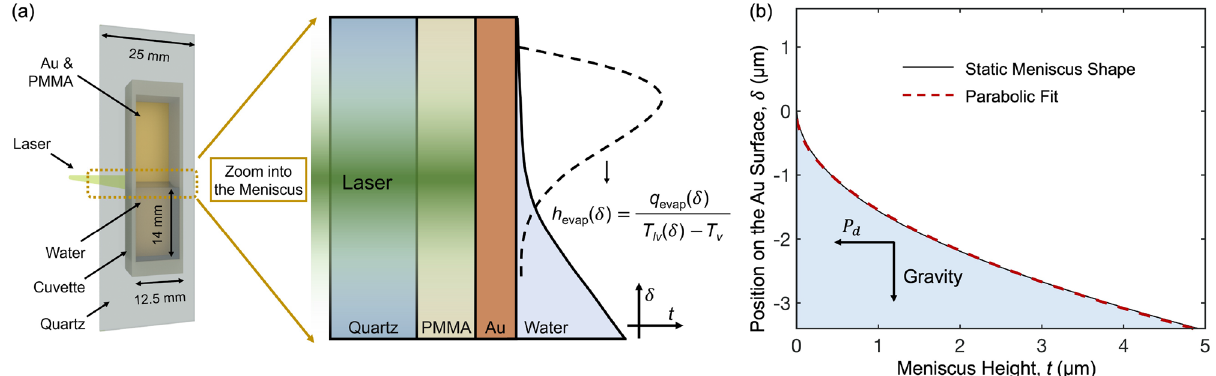
Figure 1. ( a ) Rendering of the experimental setup. The pump laser is incident from the back of the quartz slide and transmits through the PMMA layer to periodically heat the gold layer. The laser power has a Gaussian profile in the radial direction. The dashed line in the right panel illustrates the expected shape of the h evap profile 32,39 . ( b ) Static meniscus shape calculated from the augmented Young-Laplace equation without retardation effects. The red dashed curve is a parabolic